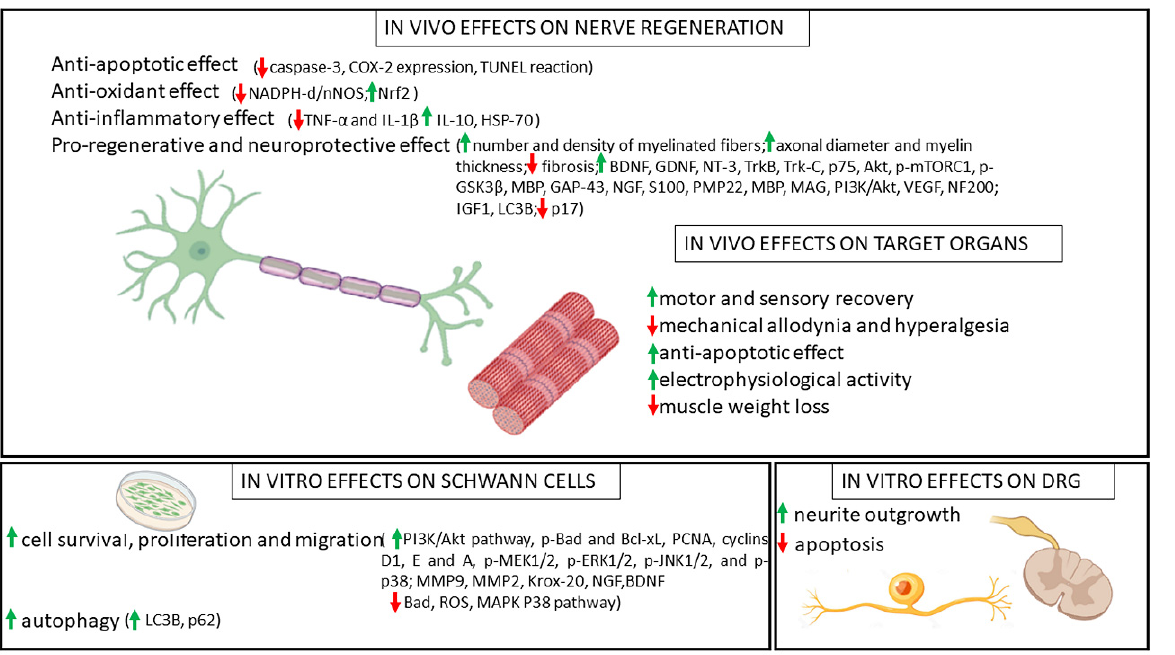
Figure 3. Beneficial effects of polyphenols on nerve regeneration with details of molecular mecha- nisms .